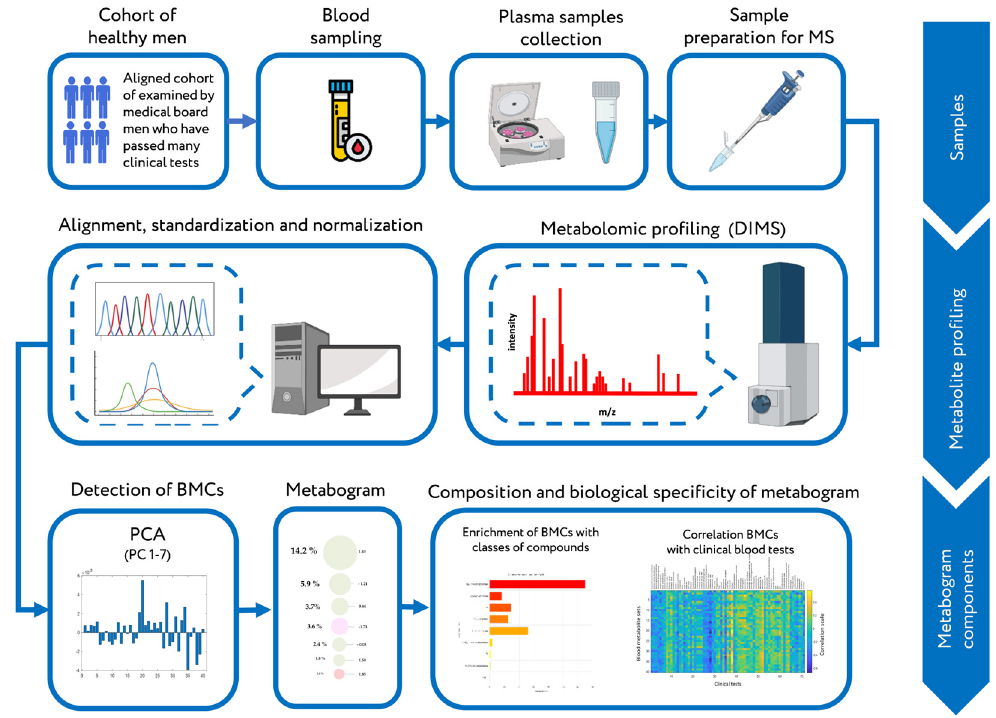
Figure 1. The workflow used to develop and characterize mass spectrometric blood metabogram. Blood plasma samples were taken from healthy people and after sample preparation, the mass spectra of blood metabolites were obtained by direct infusion mass spectrometry (DIMS). After data preprocessing (alignment, standardization, and normalization), the resulting lists of mass peaks were analyzed using principal component analysis (PCA) to identify the blood metabolome components (BMCs). The first seven BMCs formed the metabogram components. To characterize each metabogram component, their composition was determined by identifying the chemical classes with which they are enriched by applying a metabolite set enrichment analysis (MSEA). To clarify the biological specificity of the metabogram components, clinical blood tests were